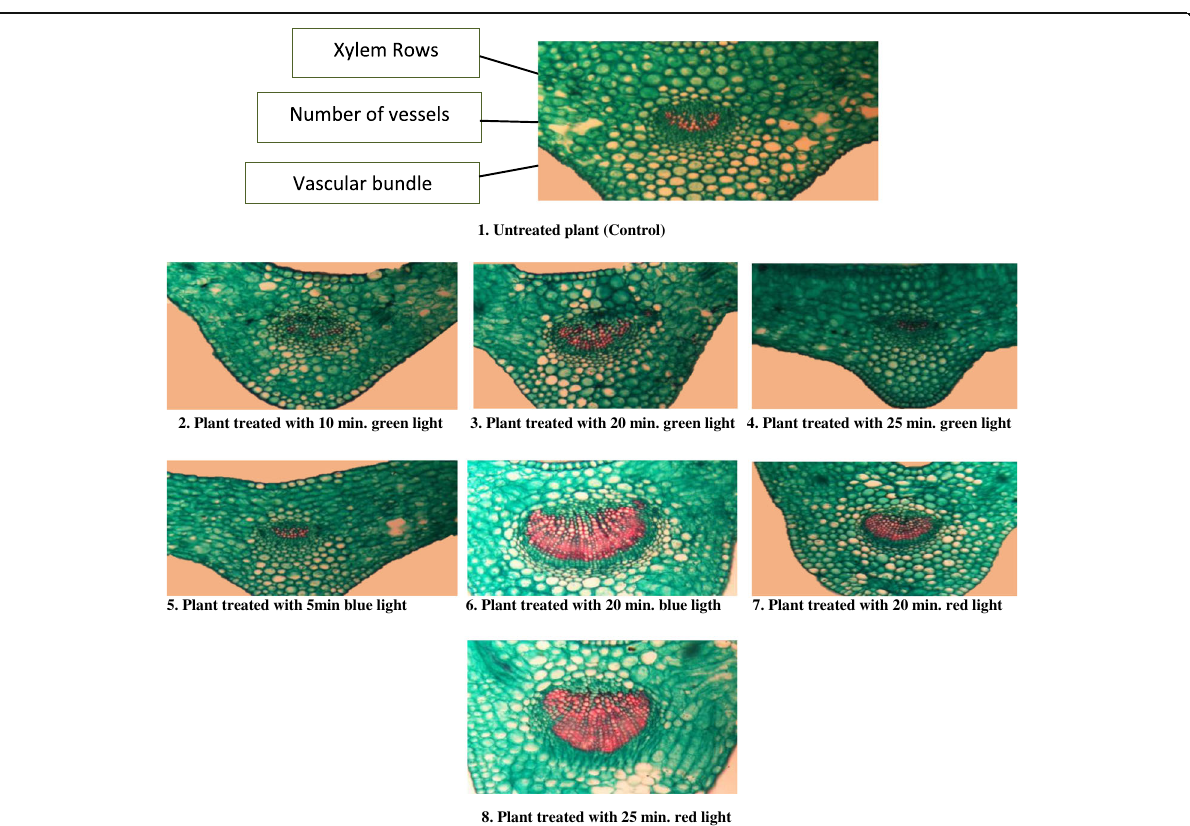
Fig. 7 Light microphotograph showing transverse section through the blade of the third in vitro plant leaf developed on the main stem of Eustoma grandiflorum plantlets. The section shows vascular bundle, (number of vessels and number of xylem rows. (× 40)(Bar = 0.05 ml). VR vascular bundle, XR xylem rows, NV number of